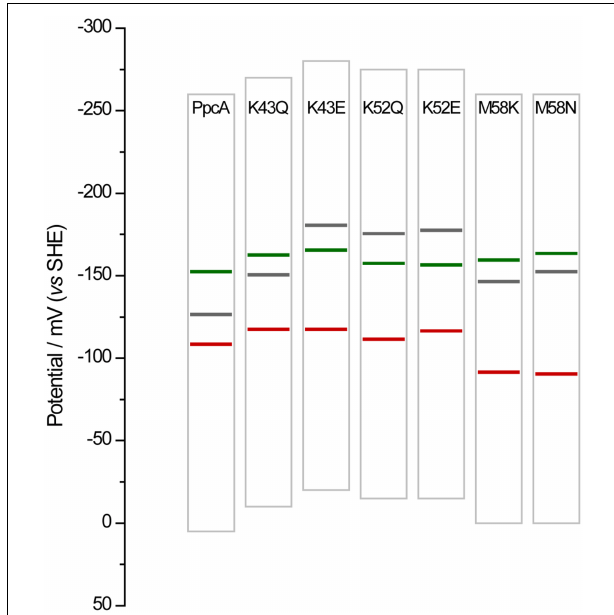
FIGURE 8 | Histogram comparison of the redox-active windows of wild-type PpcA and mutants showing increased differences between the e app - values of the third and second heme to oxidize 1 e app (3 rd /2 nd ) . Horizontal lines represent the reduction potentials of the hemes I, III, and IV (see Table 4 ) colored in green, red and black, respectively. The potential windows were determined from potentiometric redox titration curves considering 1–99% of the range for protein